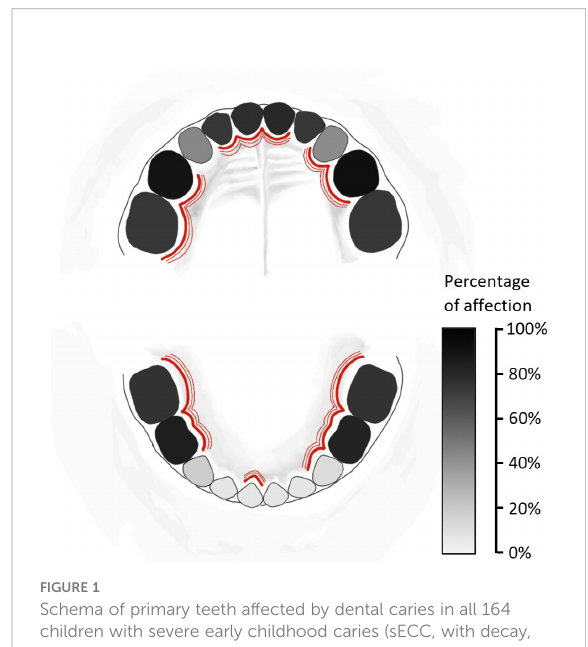
FIGURE 1 Schema of primary teeth affected by dental caries in all 164 children with severe early childhood caries (sECC, with decay, missing, fi lled teeth for caries, dmft ≥ 6) included in this study. The percentage of affection of individual teeth by dental caries is expressed using the greyscale. For bacterial sampling, teeth affected by dental caries were selected – these teeth are marked by red